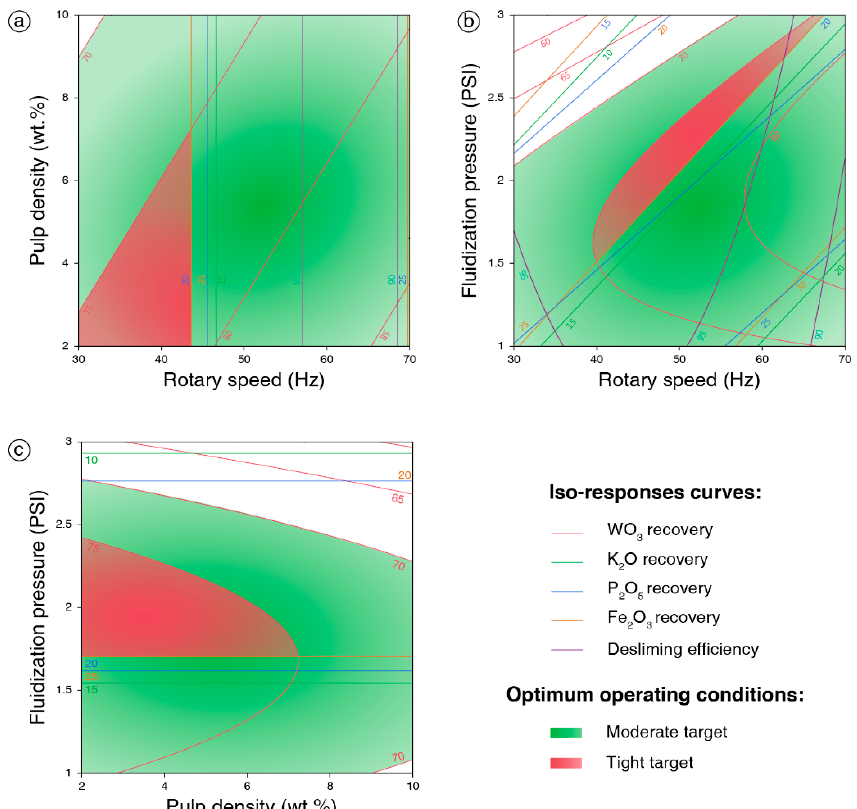
Figure 6 . 2-D contour plots for the five studied responses (WO 3 , K 2 O, Fe 2 O 3 , and P 2 O 5 recoveries and desliming efficiency) for the Falcon SB models as a function of the operating parameters ( a ): pulp density and rotary speed; ( b ): fluidization pressure and rotary speed; ( c ): fluidization pressure and pulp density). Targets represent zones where the objectives set on all the studied responses, defined in Table 3, are reached. Table 9. Validation test for the Falcon SB based on a test with optimized parameters ( ω = 58